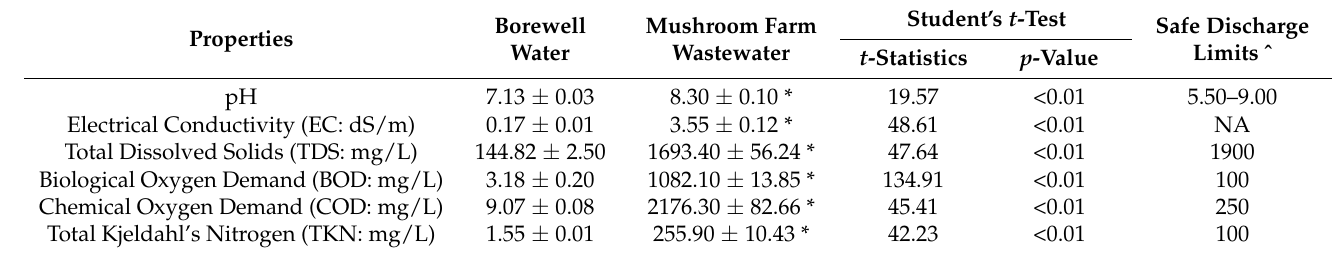
Table 1. Physicochemical characteristics of borewell water and mushroom industry wastewater used in this